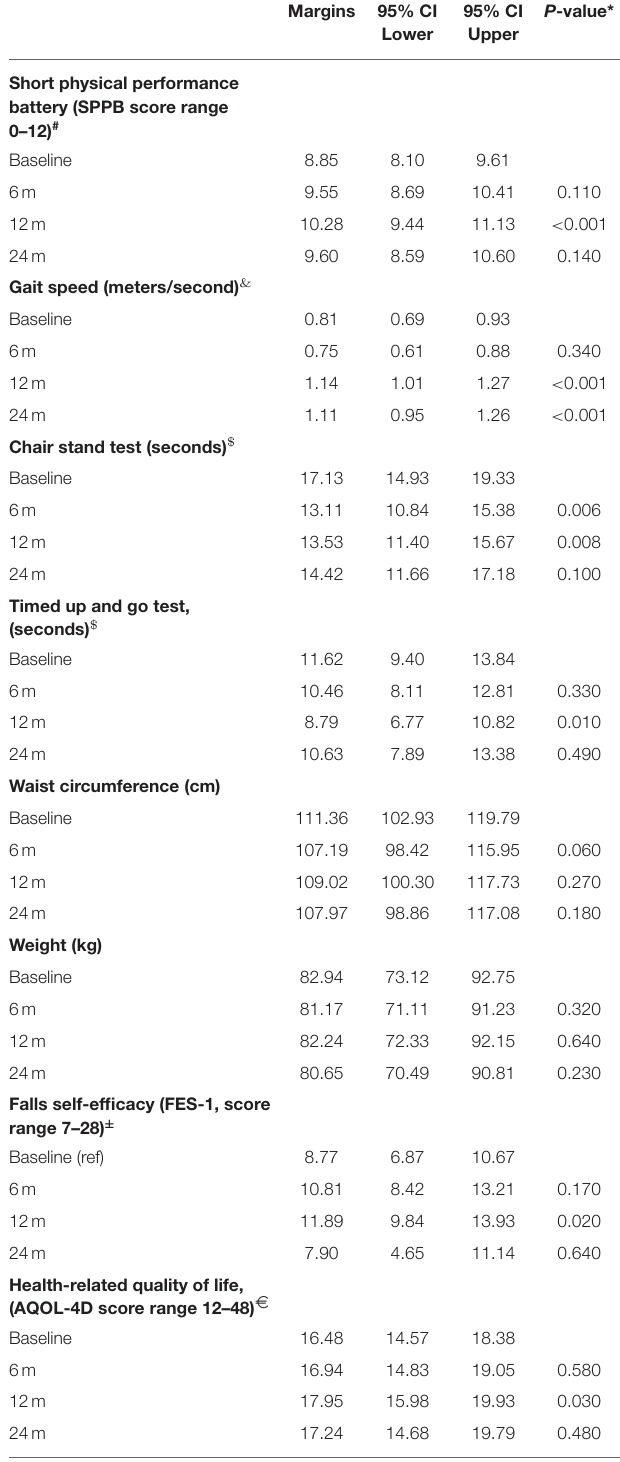
TABLE 2 | Predicted marginal mean health outcomes over four time points.